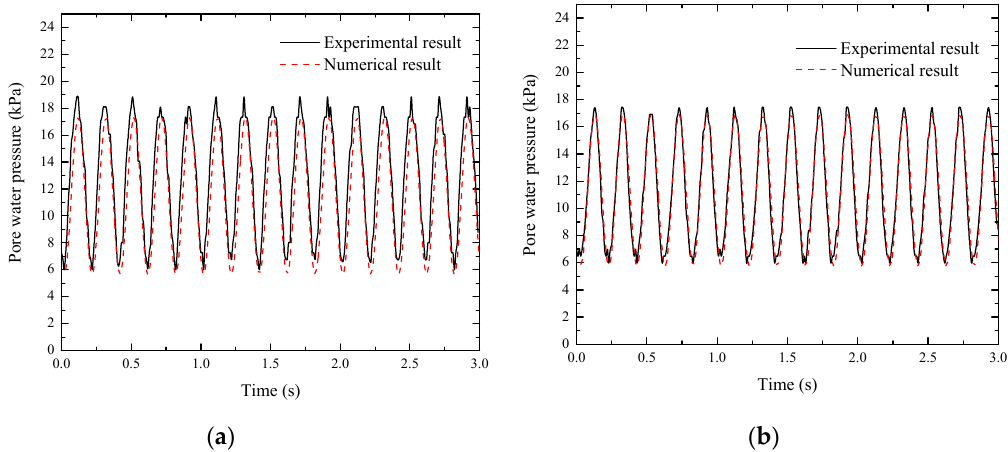
Figure 4. Lab-test model and numerical model: ( a ) Lab-test model, ( b ) numerical model developed in LS-DYNA, and ( c ) cross section of the numerical model.